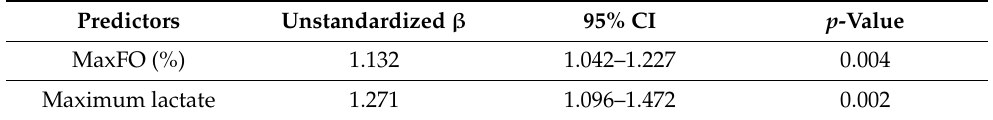
Table 3. Multivariate linear regression model for PICU LOS.